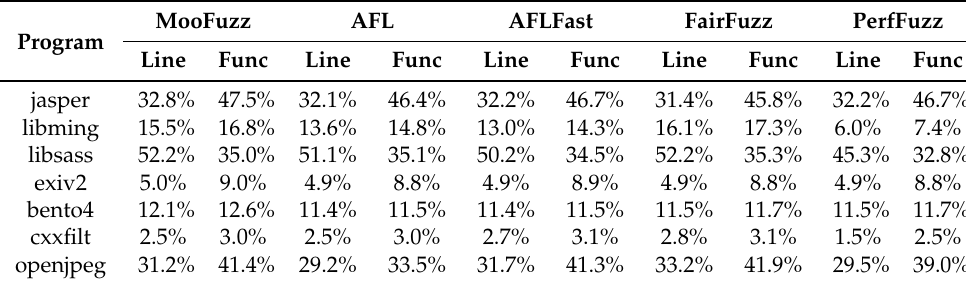
Table 4. Line and function covered by